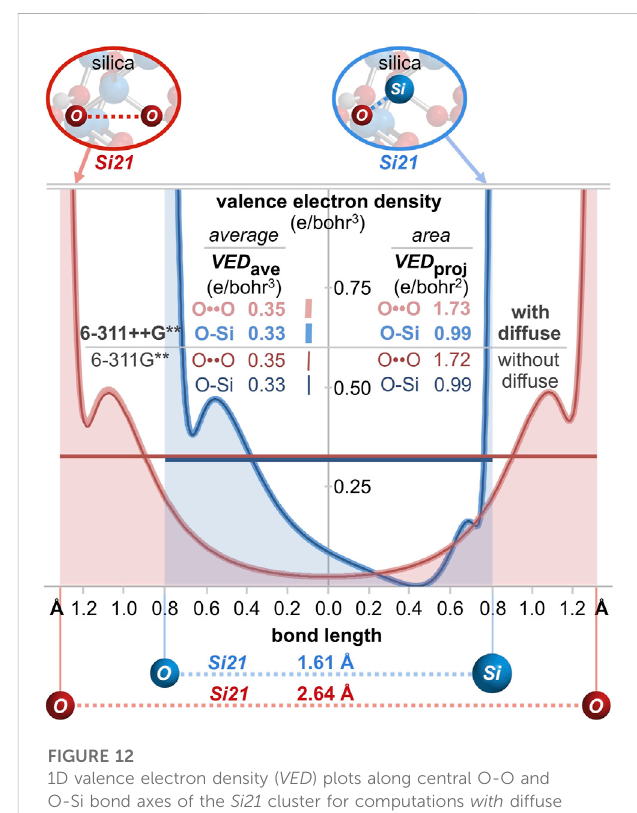
O-Si bond axes of the Si21 cluster for computations with diffuse functionals (thick lines; 6-311++G**) and without diffuse functionals (thin lines; 6-311G**). The curves are nearly coincident while the VED ave and VED proj values are greater for O-O than for O-Si, demonstrating a de fi nitive excess of valence electrons employed for oxygen-oxygen bonding — regardless of diffuse functional